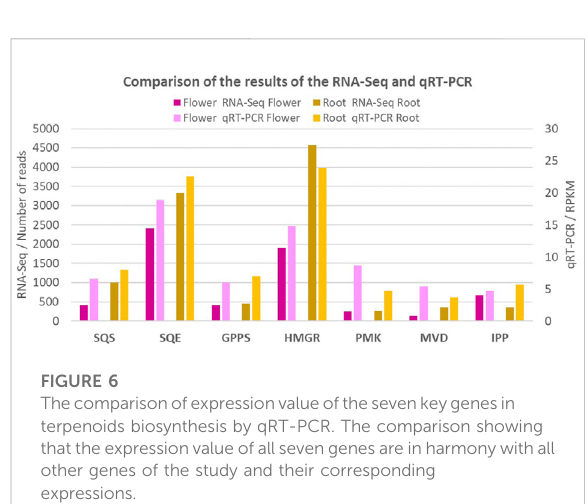
FIGURE 6 Thecomparisonofexpressionvalueofthesevenkeygenesin terpenoids biosynthesis by qRT-PCR. The comparison showing that theexpressionvalue of all seven genes are in harmony with all other genes of the study and their corresponding expressions.